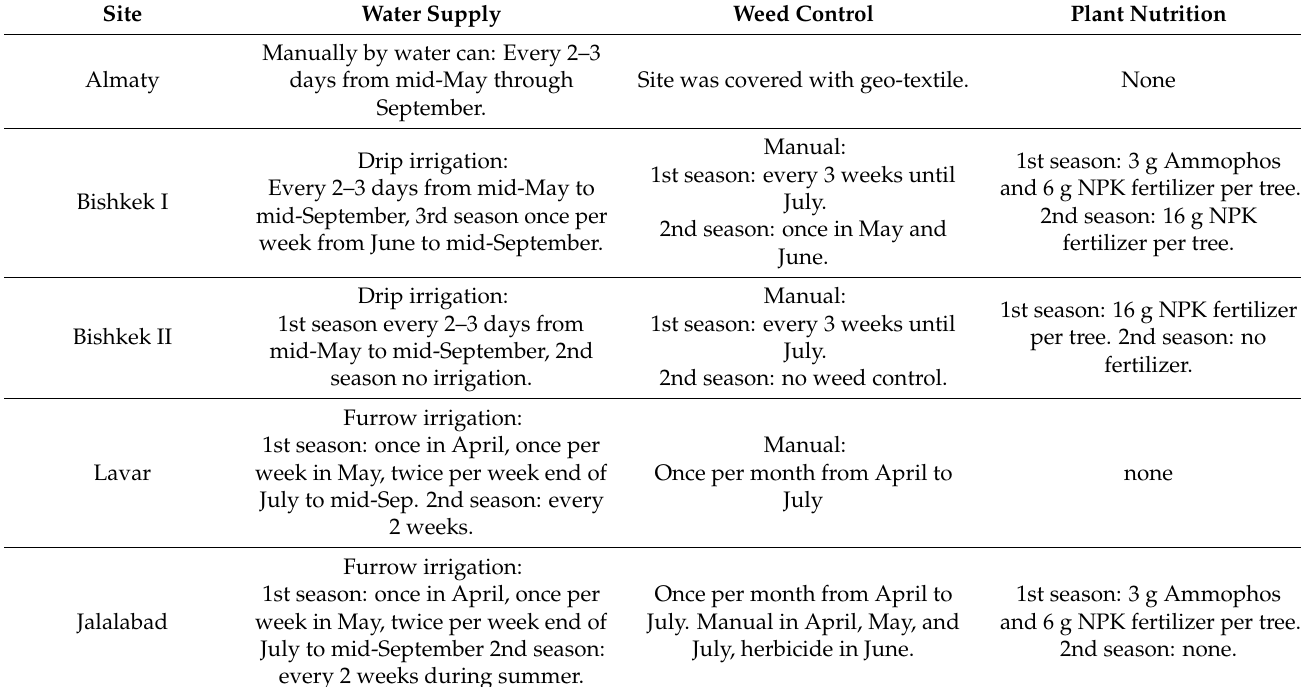
Table 5. Water supply, weed control, and plant nutrition by site. Ammophos contained 12% N and 52% P 2 O 5 . The NPK fertilizer contained 25.6% N, 6.6% P 2 O 5 , and 21% K 2